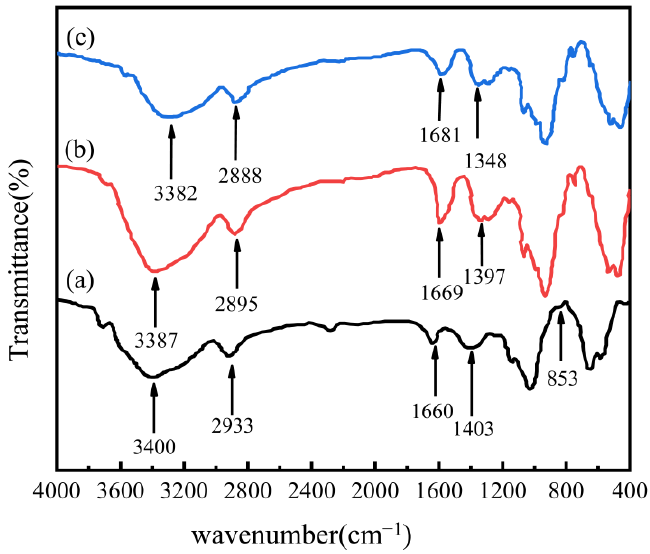
Figure 1. FTIR spectra for AAM-MSM ( a ), AAM-MSMPM ( b ), and Cd(II)/AAM-MSMPM ( c ).